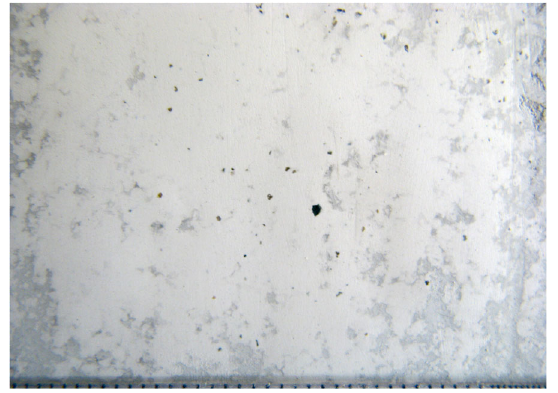
Fig. 21 Ludwig Mies van der Rohe and Lilly Reich, House Tugendhat, Brno, 1930, bedroom Grete Tugendhat, south-east wall, behind the closet (bottom edge photo approx. 4.5 cm), sanding test of the original ‘ stucco lustro ’ , with particles of pigmenting fine sand (Source: Ivo Hammer